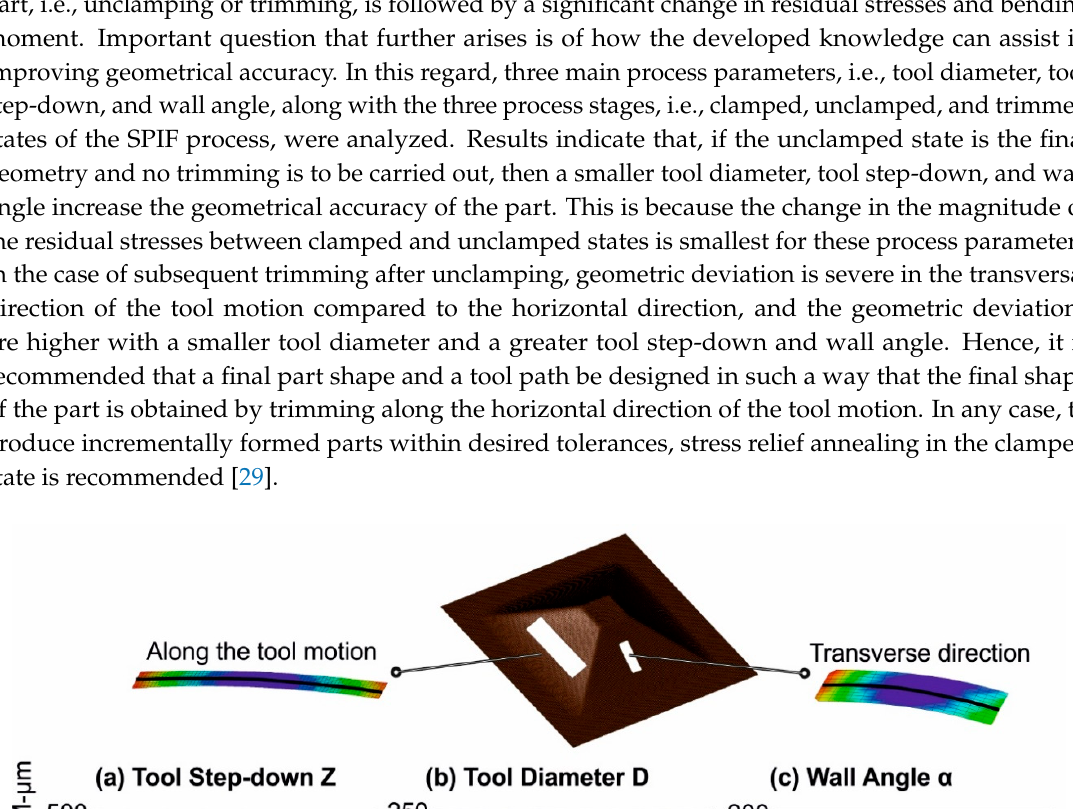
Figure 18. ( a ) Curvature of a strip for large wall angle in the transverse direction. ( b ) Curling of a strip cut along the tool motion toward the transverse direction for large wall angle. ( c ) Curvature of a strip for small wall angle in the transverse direction.